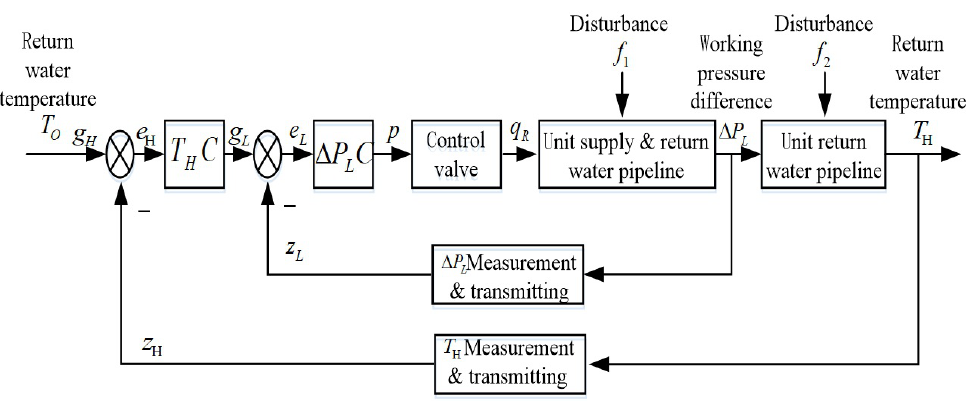
Fig. 4 Control system’s principle